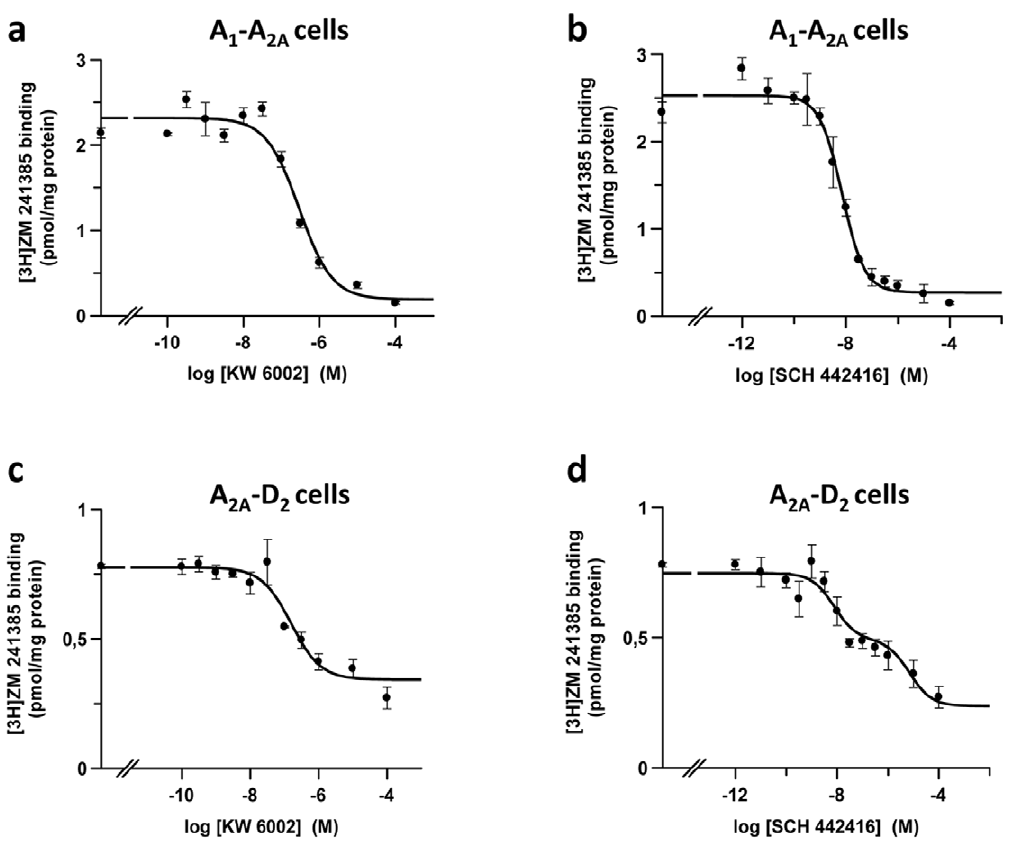
Figure 7. Binding of the A 2A R antagonists KW-6002 and SCH-442416 to A 1 R-A 2A R and A 2A R-D 2 R CHO cells. Competition experiments of [ 3 H]ZM-241385 (2 nM) versus increasing concentrations of KW-6002 (a and c) or SCH-442416 (b and d) were performed as indicated in Methods in membrane preparations from CHO cells expressing A 1 R and A 2A R (a and b) or A 2A R and D 2 R (c and d). Data are means 6 S.E.M. of a representative experiment performed with triplicates.